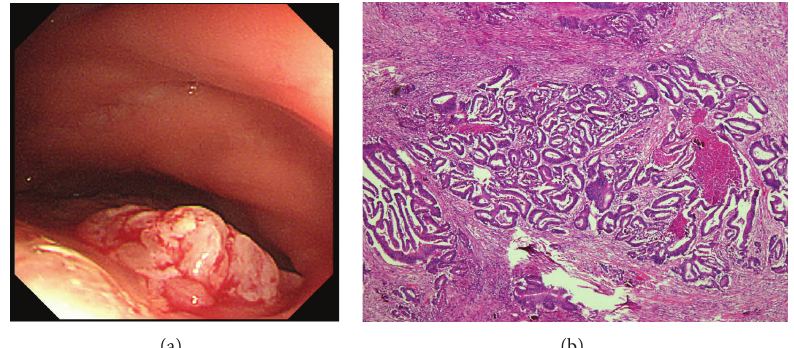
Figure 3: (a) Colonoscopy revealed the tumor to be an ulcerated rectal mass 20 cm from the anal area. (b) Histopathological examination of a biopsy revealed the tumor to be an adenocarcinoma of the rectum ( × 20).